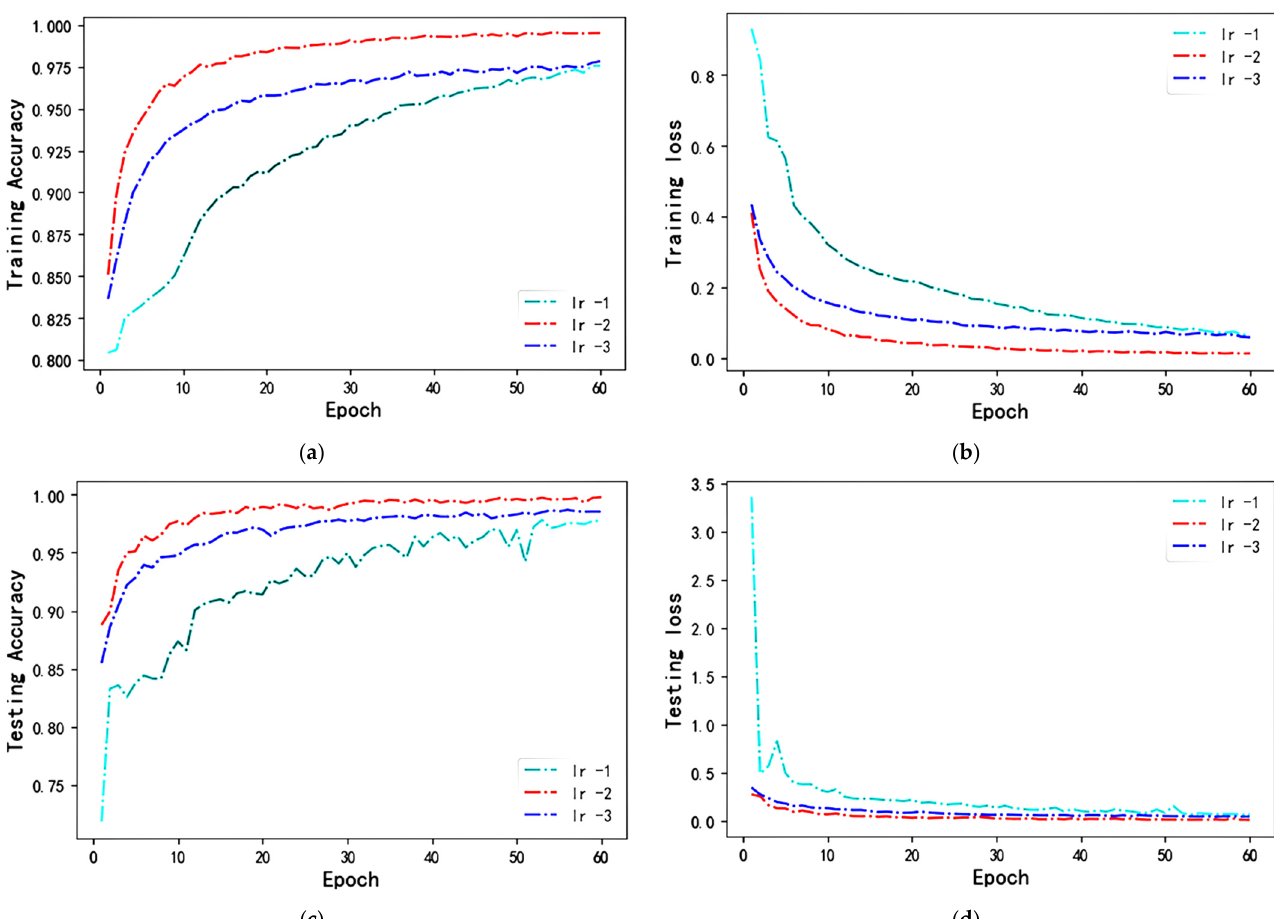
Figure 9. Training and testing accuracy and loss value curves of different learning rates. ( a ) Train- ing accuracy; ( b ) Training loss; ( c ) Testing accuracy; ( d ) Testing loss. accuracy; ( b ) Training loss; ( c ) Testing accuracy; ( d ) Testing